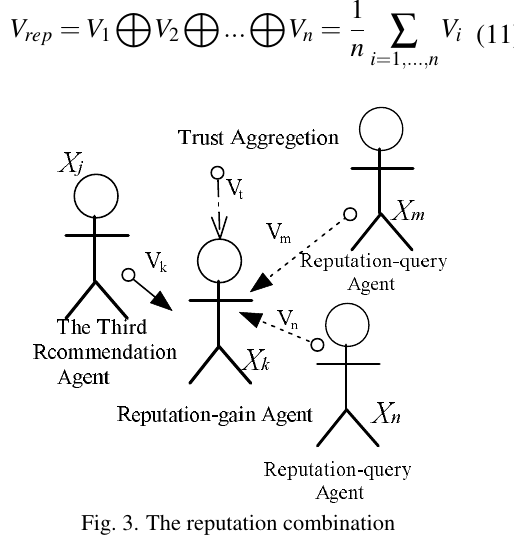
Fig. 3. The reputation combination